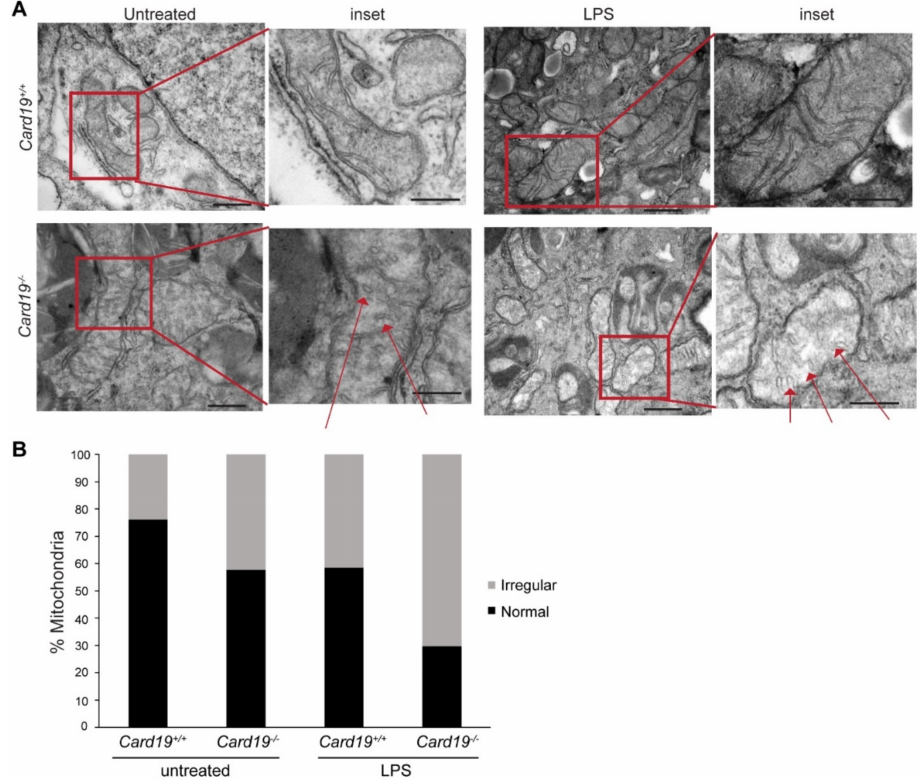
Figure 4. Mitochondria in Card19 − / − BMDMs have an increased proportion of irregular cristae in comparison to WT BMDMs. ( A ) BMDMs from Card19 +/+ or Card19 − / − mice were either untreated or treated with LPS (100 ng/mL, 3 h), then analyzed via TEM. Insets are magnified views of mitochondria indicated by red boxes; red arrows indicate observed vesicular cristae ( B ) Mitochondria with visible cristae were counted and classified as either normal (lamellar) or irregular (swollen, vesicular). Results are presented as the percentage of either normal or irregular cristae of the total mitochondria counted for each